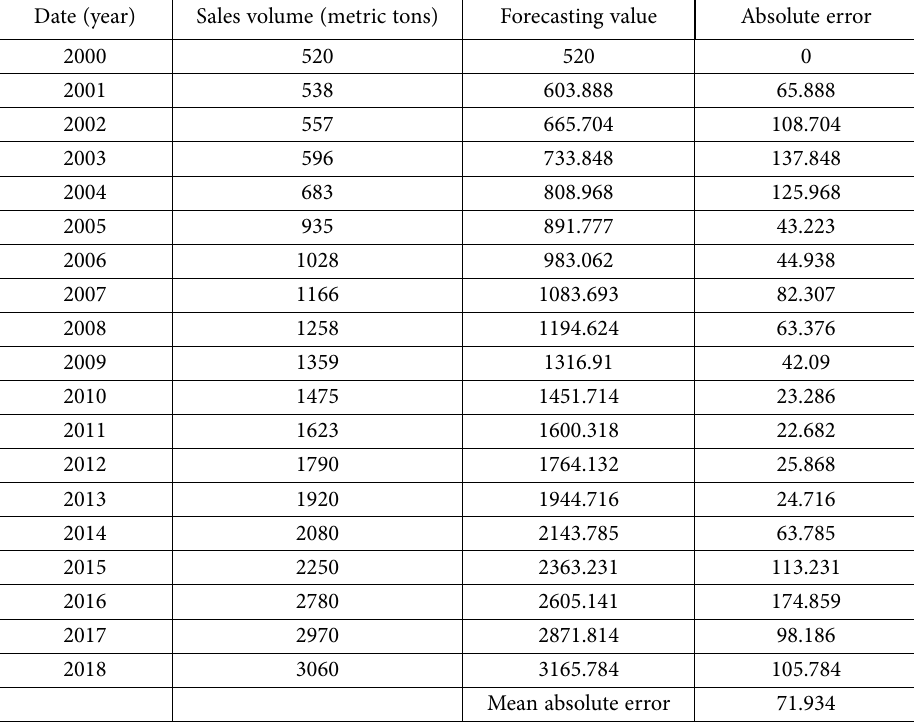
Table 4. Forecasting value of the 2000–2018 sales volume based on the grey